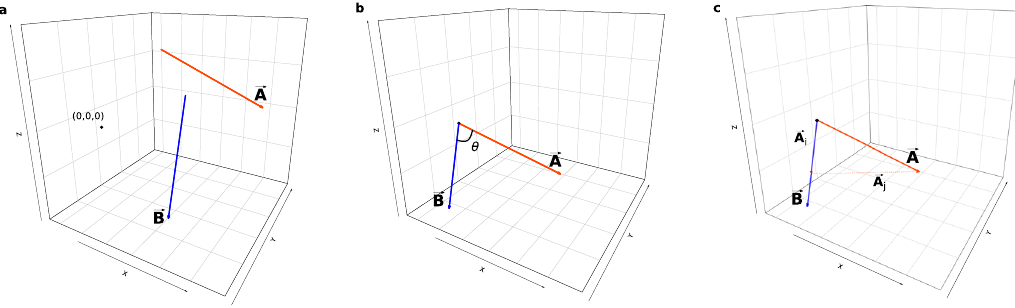
Fig. 2 A synthesized example of the SORD vector-direction comparison methodology. After scaling the environmental variables across the study area, we plotted the SORD vectors (exempli fi ed here by ~ A and ~ B) with the initial point of each vector at the centroid of the source population and the terminal point of each vector at the centroid of the seedling-only population ( a ). We then translocated the vectors to the origin and found the angle θ between them ( b ) and calculated the cosine of θ which is equivalent to j